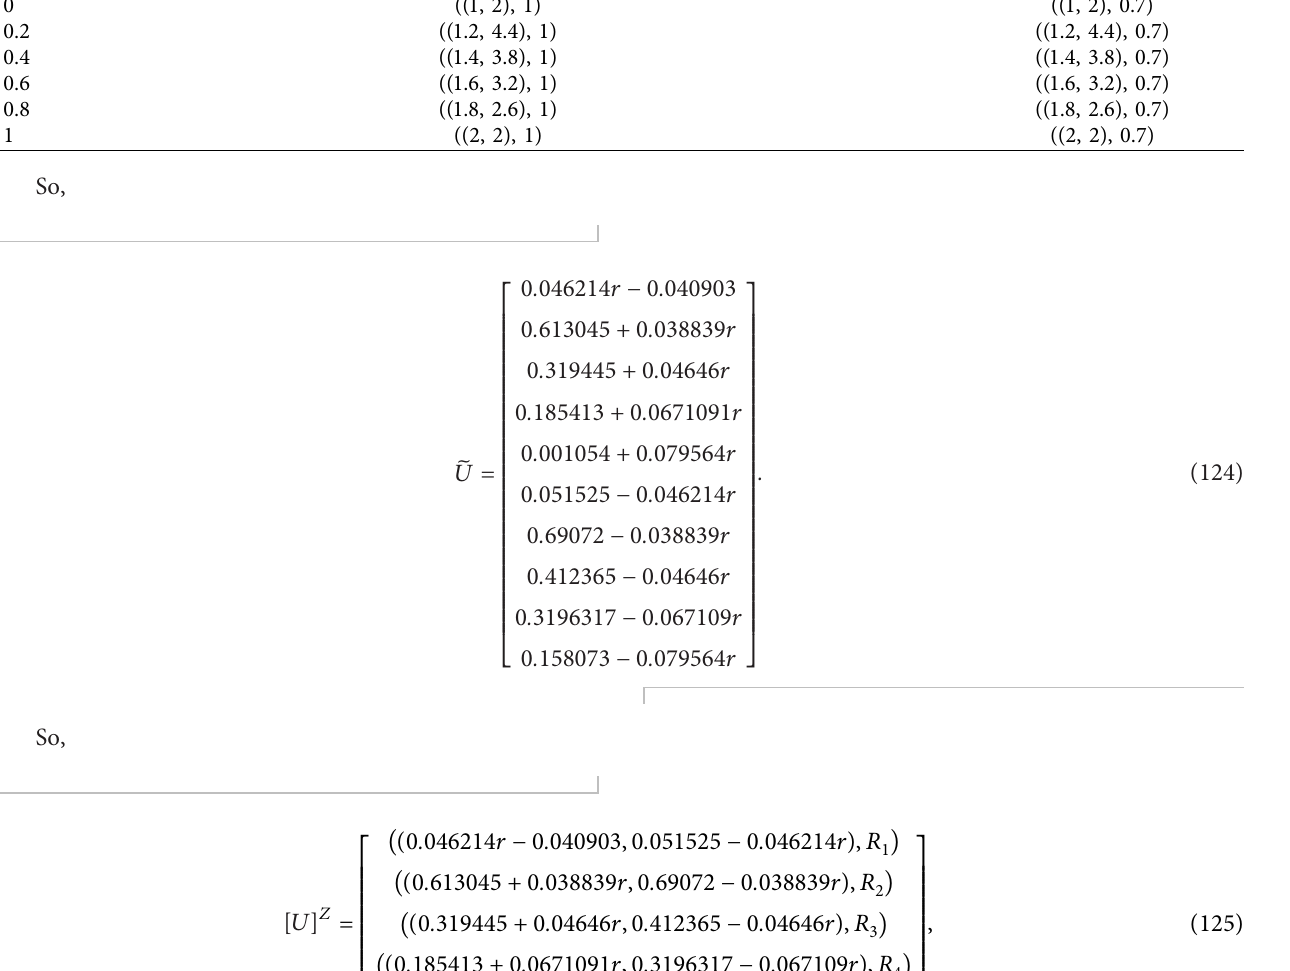
Table 10: Comparison of 􏽥 u ( r ) result using the two proposed methods ( λ � 0). 2 Te frst proposed method ( λ � 0